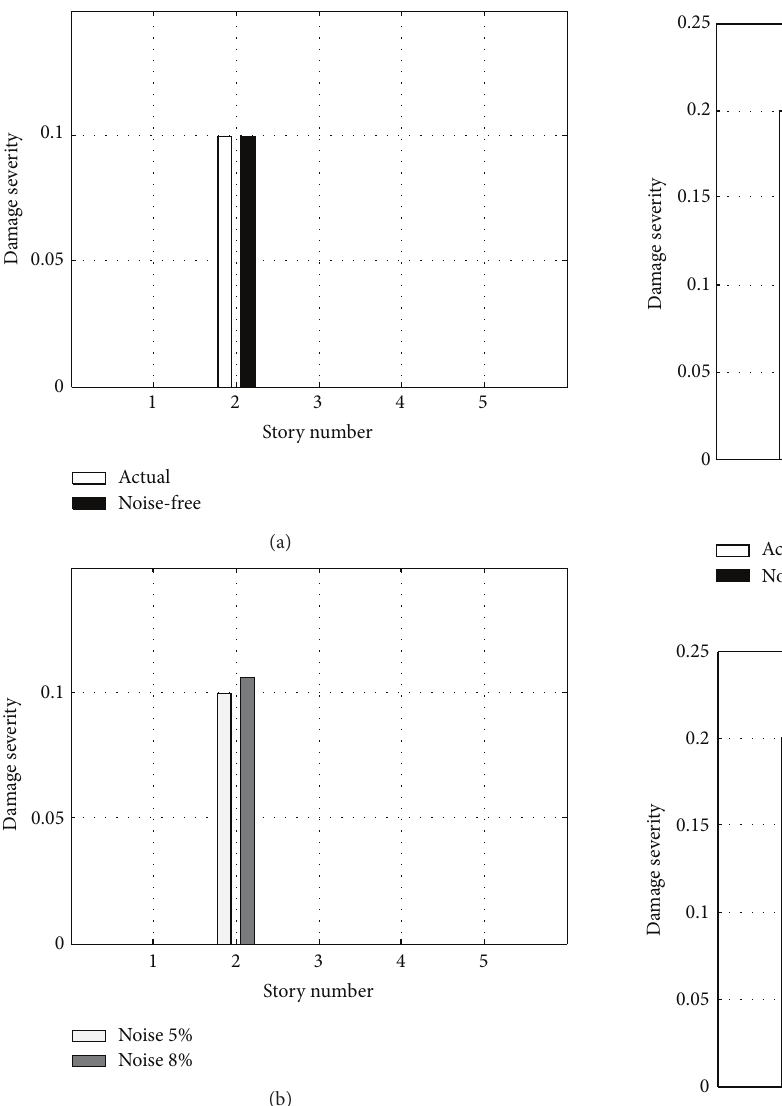
Figure 3: Damage detection results in the five-story shear frame for scenario I.